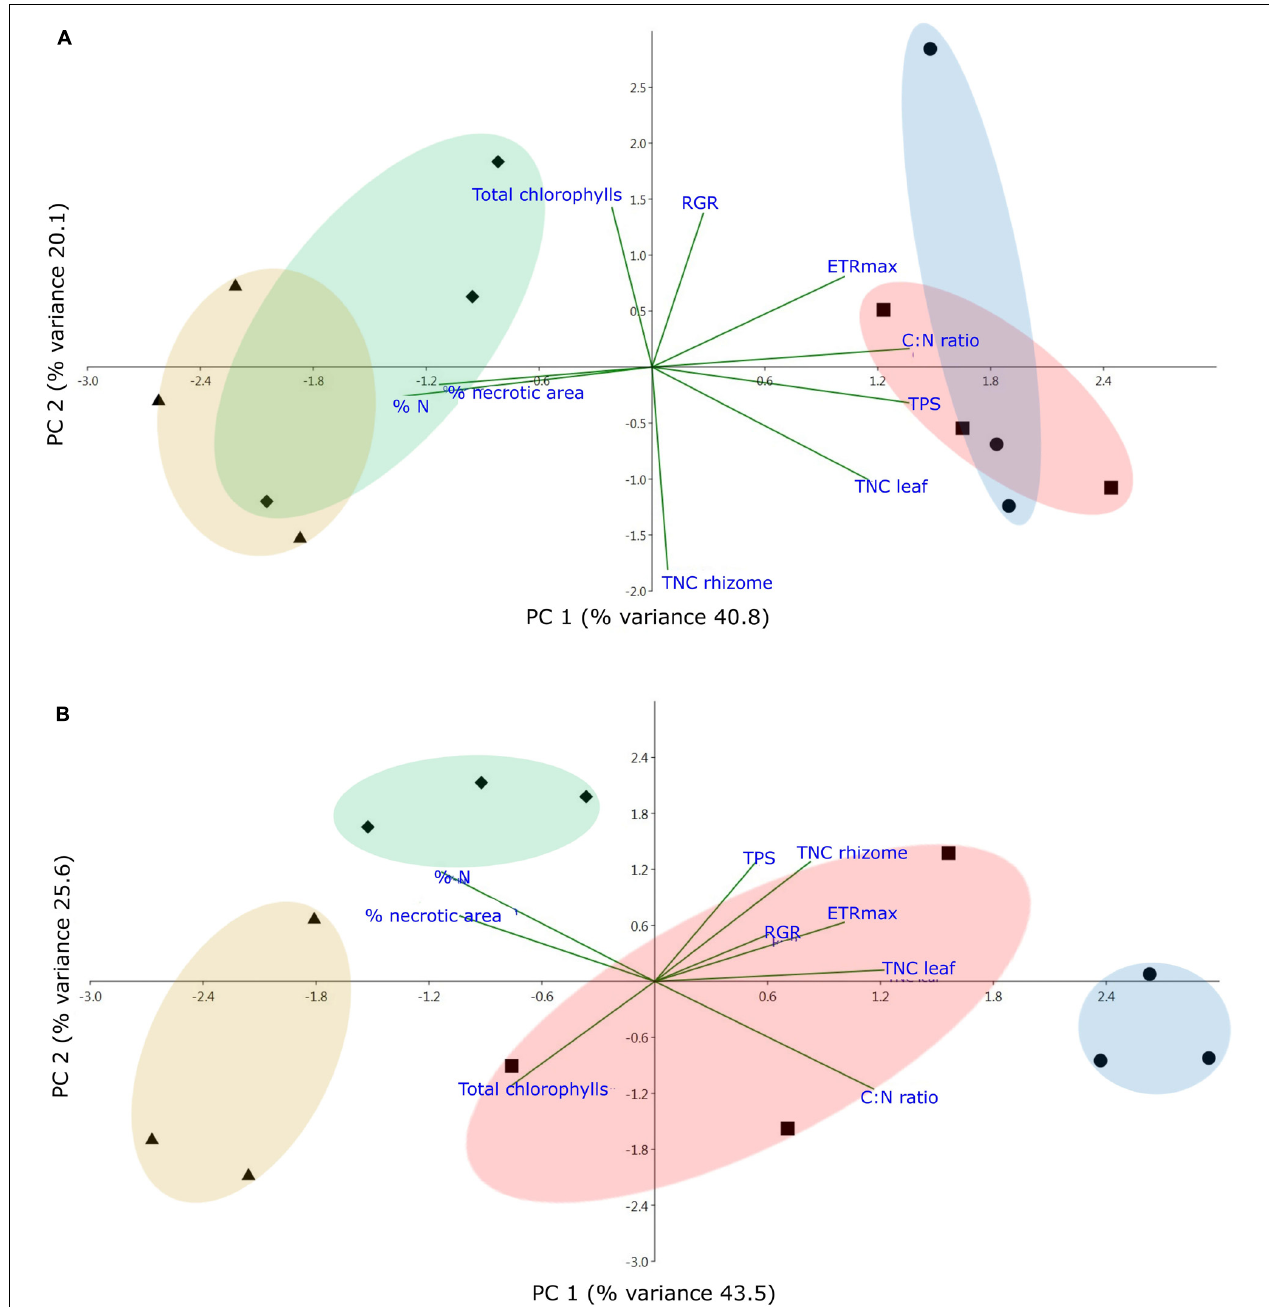
FIGURE 5 | Principal Component Analysis (PCA) performed on (A) EU (eutrophic) and (B) OL (oligotrophic) plants at the end of the experiment considering all variables: nitrogen content (%N), carbon and nitrogen ratio (C:N), total chlorophyll, maximum electron transport rate (ETR m ), total non-structural carbohydrates in leaf (TNC leaf) and rhizome (TNC rhizome), % necrotic area, total photosynthetic surface (TPS) and relative growth rate (RGR). Different colored circles and symbols refer to different treatments ( • = Control; (cid:78) = Nutrients; (cid:4) = Temperature; (cid:7) = Nutrients +